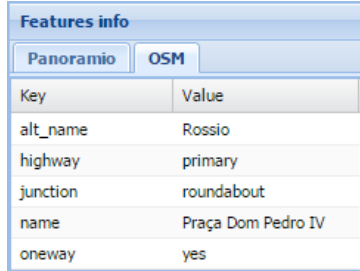
Figure 7. Detail of the Features info view for an OSM selected feature.